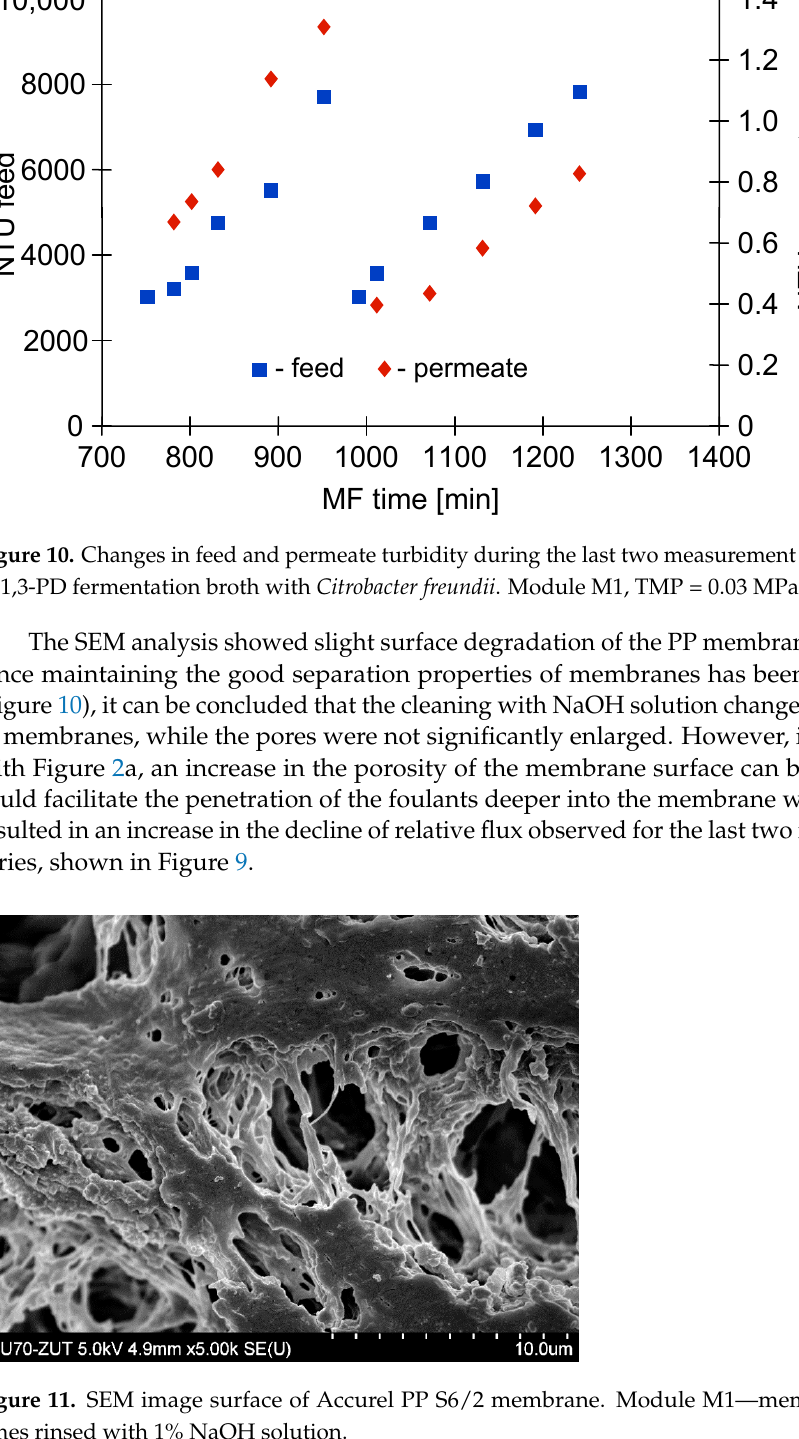
backwashing H 3 PO 4 Figure 12. The efficiency of cleaning the ceramic membrane after the MF of 1,3-PD fermentation broth with Citrobacter freundii (V F = 5.5 m/s. TMP = 0.08 MPa). Operation time: water—30 minutes, NaOH—5 minutes, backwash—5 minutes, acid—10 minutes. It has been demonstrated that the membrane rinsing with distilled water for 30 min allowed to recover the maximum membrane permeability in 40% (Figure 12). Then, in order to increase the cleaning efficiency, 3% NaOH solution was used. It has been found that after five cycles of caustic rinsing, the M4 module performance increased to 86% of its maximum value. However, the subsequent membrane rinsing and water filtration for 30 min did not allow improving the cleaning efficiency. This result is different from that